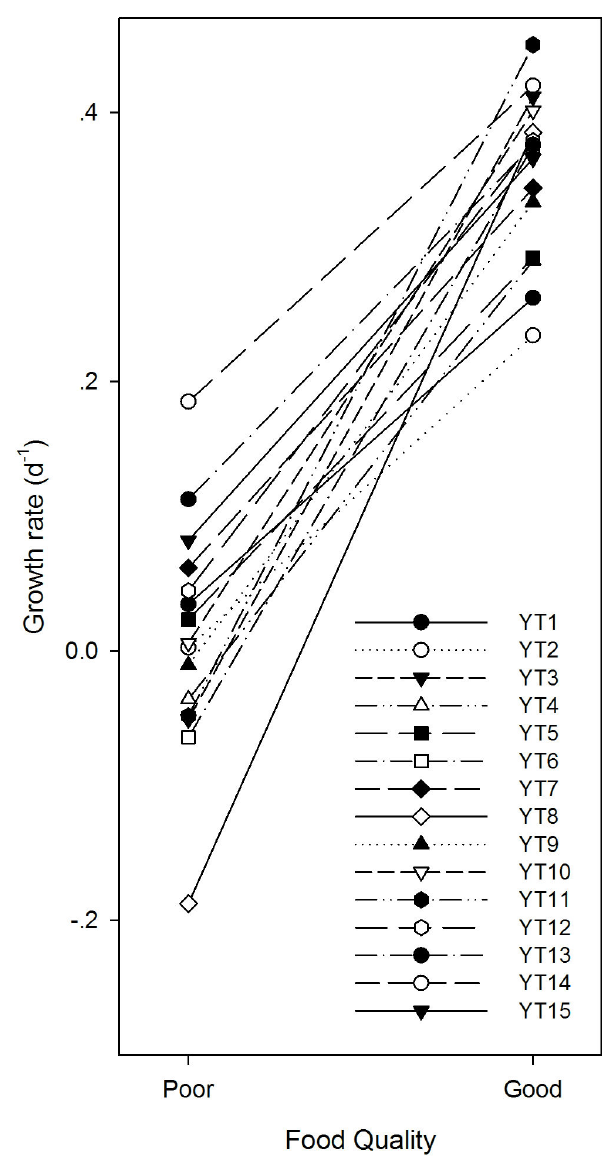
Figure 3. Reaction norms for growth rates of Bosmina longirostris feeding on the “poor” and “good” diets. Each line represents one of the 15 clones isolated from the same population.